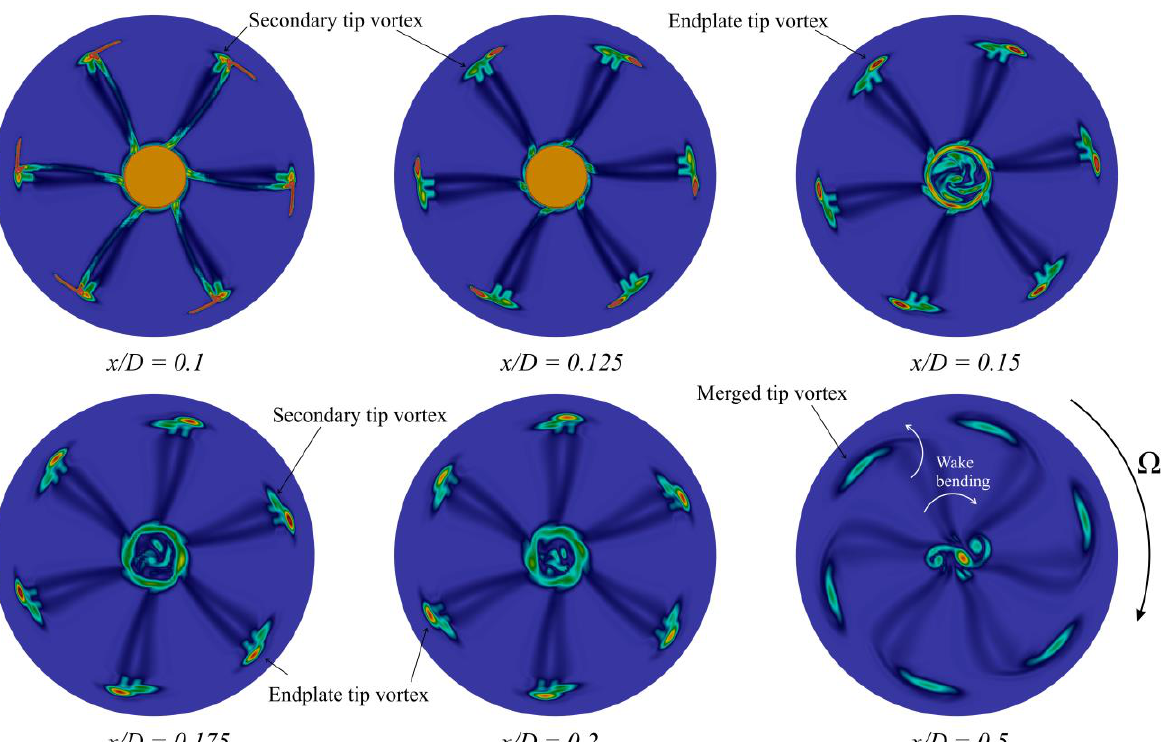
Figure 17. Transverse distributions of vorticity (magnitude) at different axial locations downstream the propeller. Conventional CLT propeller at the design advance coefficient ( J = 0.9).